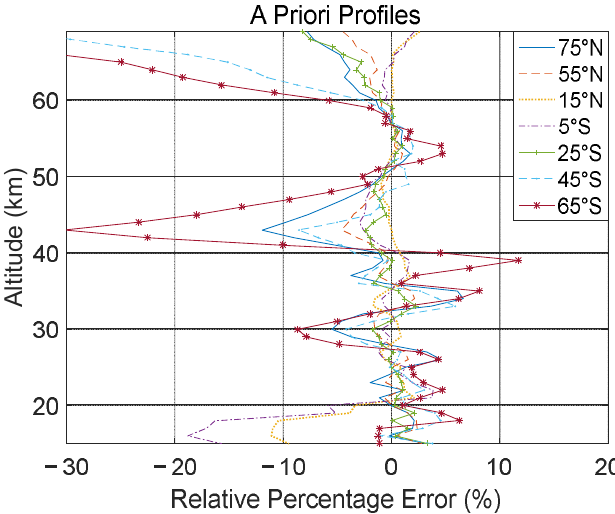
Figure 3. Relative errors attributed to a priori profiles at different latitudes.